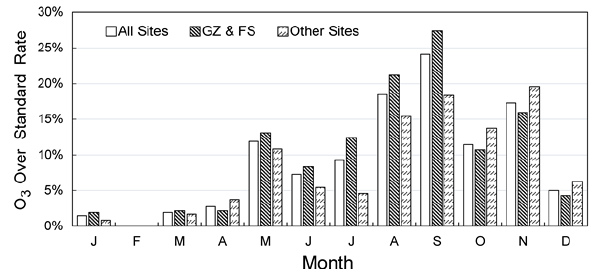
Fig. 3. Average fraction of days per month whose daily maximum 8-hr average exceeds 160 µg m -3 out of all days per month with ozone data in 2010.